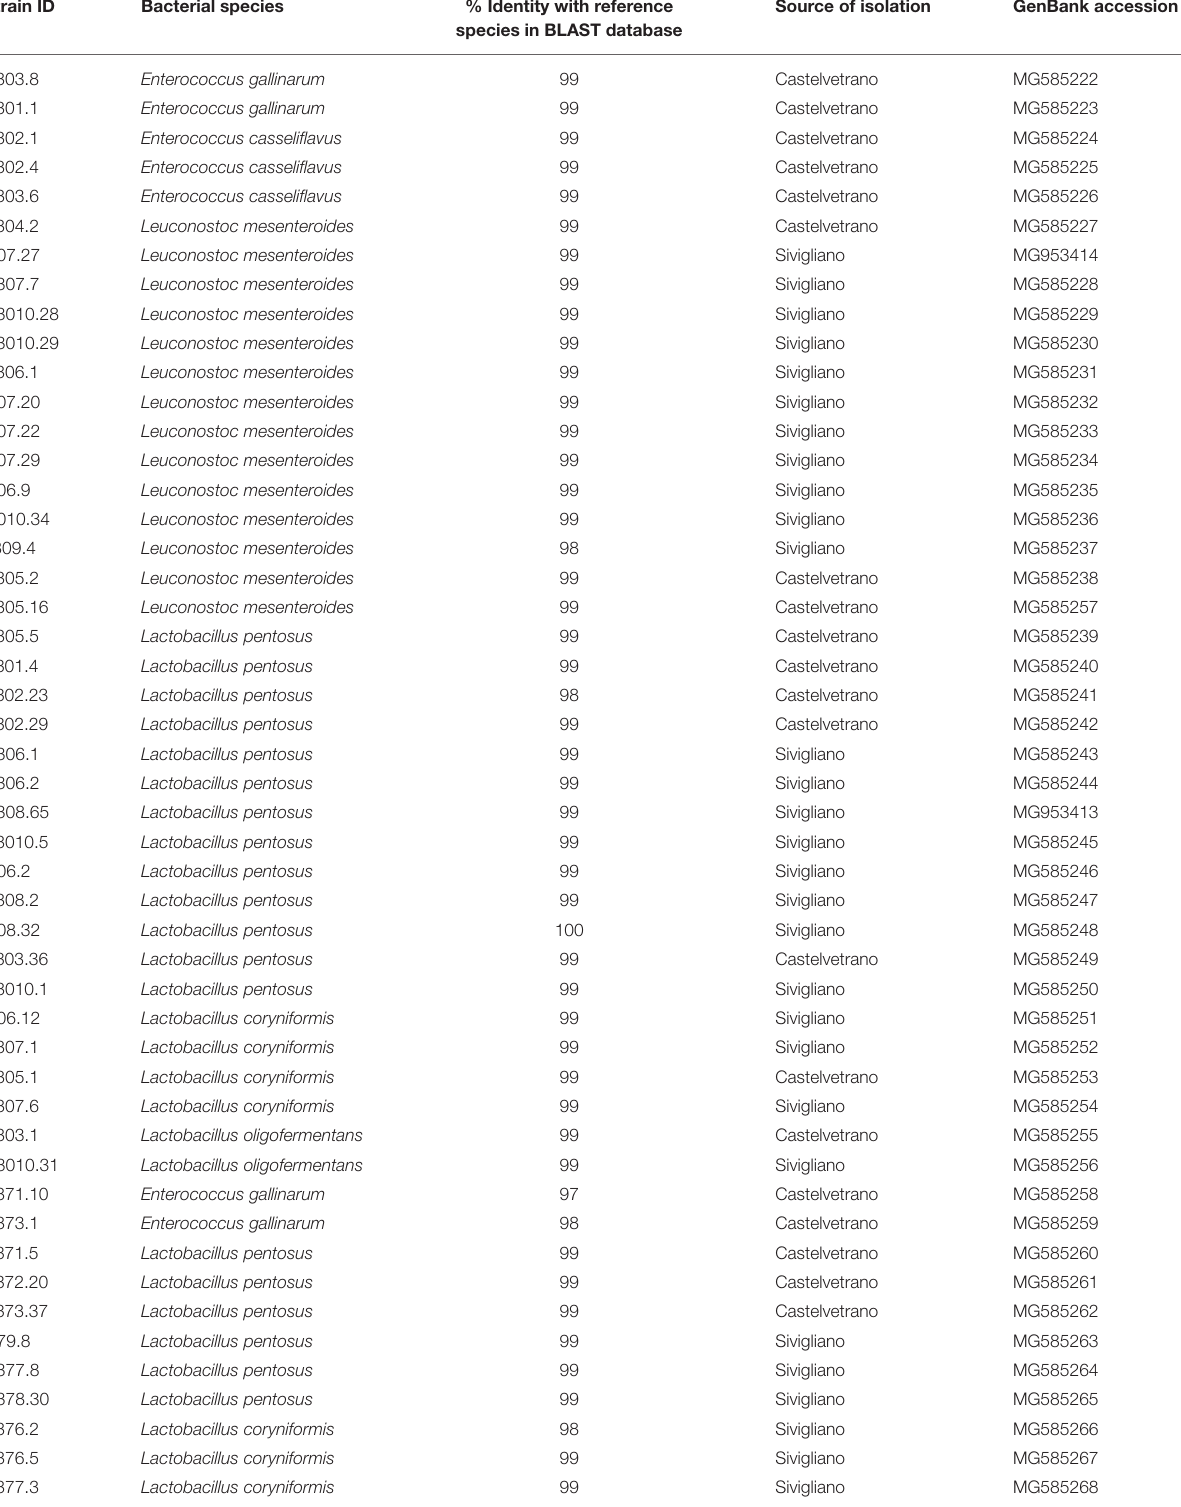
TABLE 1 | List of LAB isolates deriving from Nocellara del Belice table olives fermented with Sivigliano or Castelvetrano methods and related species identified by 16S rDNA sequencing. Strain